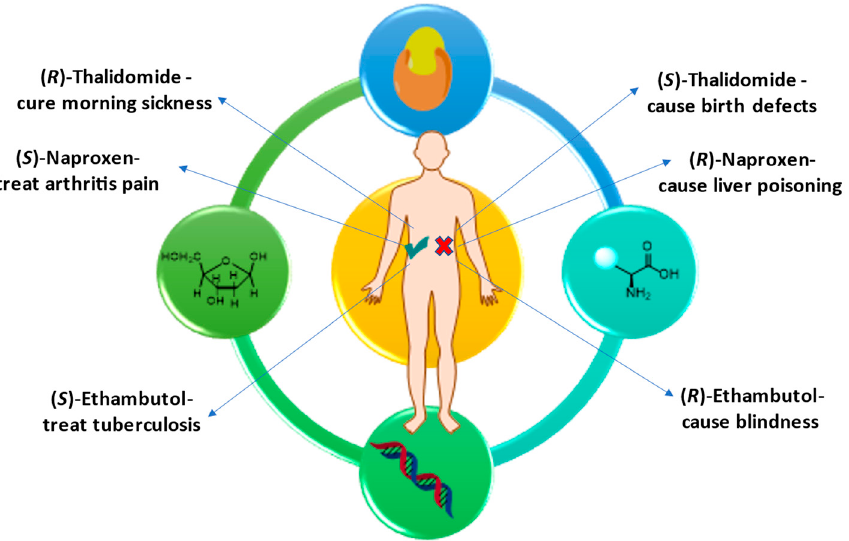
Figure 1. Existence of chirality in the human body.